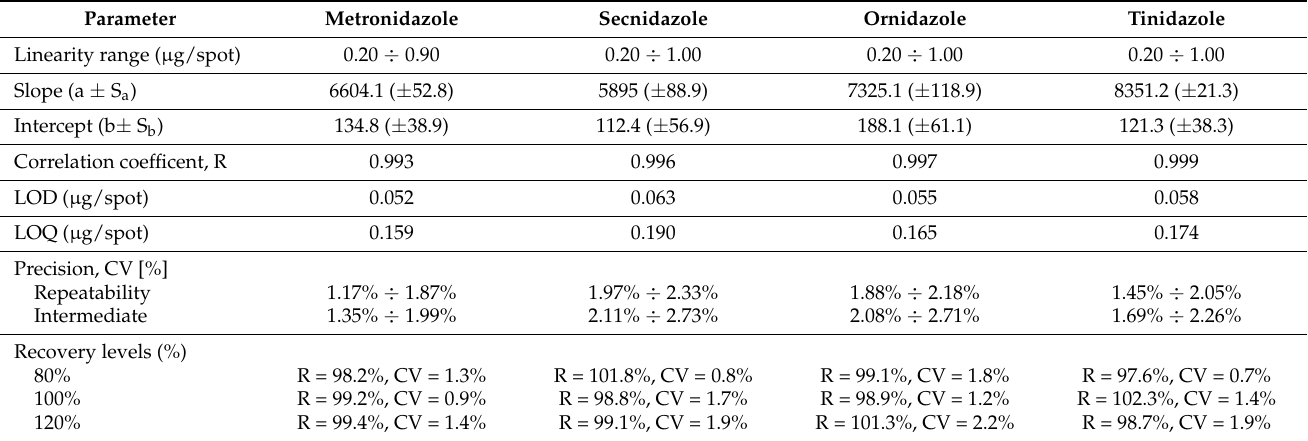
(Table 3). The low coefficient of variation values (CV < 3%) are indicative of the accuracy of the method. Table 3. Method validation